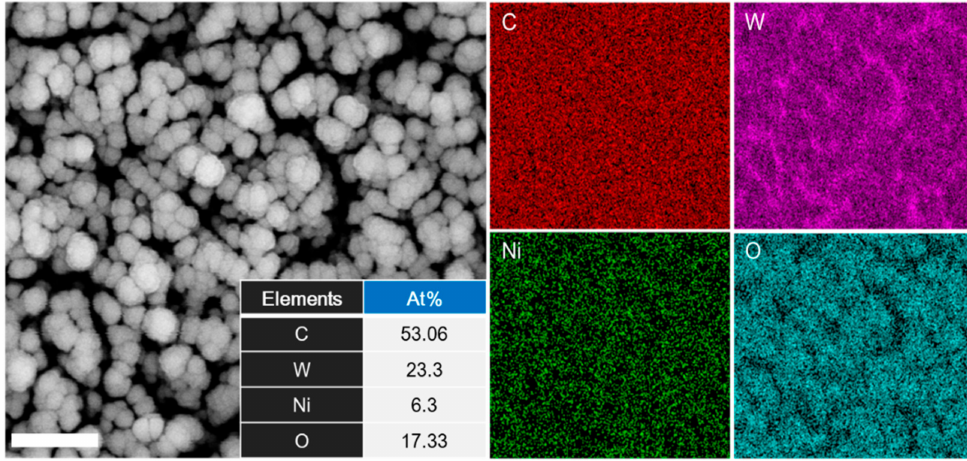
Figure 3. The comparison of the contents of carbon (C), tungsten (W), nickel (Ni), and oxygen (O) elements, calculated using EDS mapping (scale bar, 300 nm).